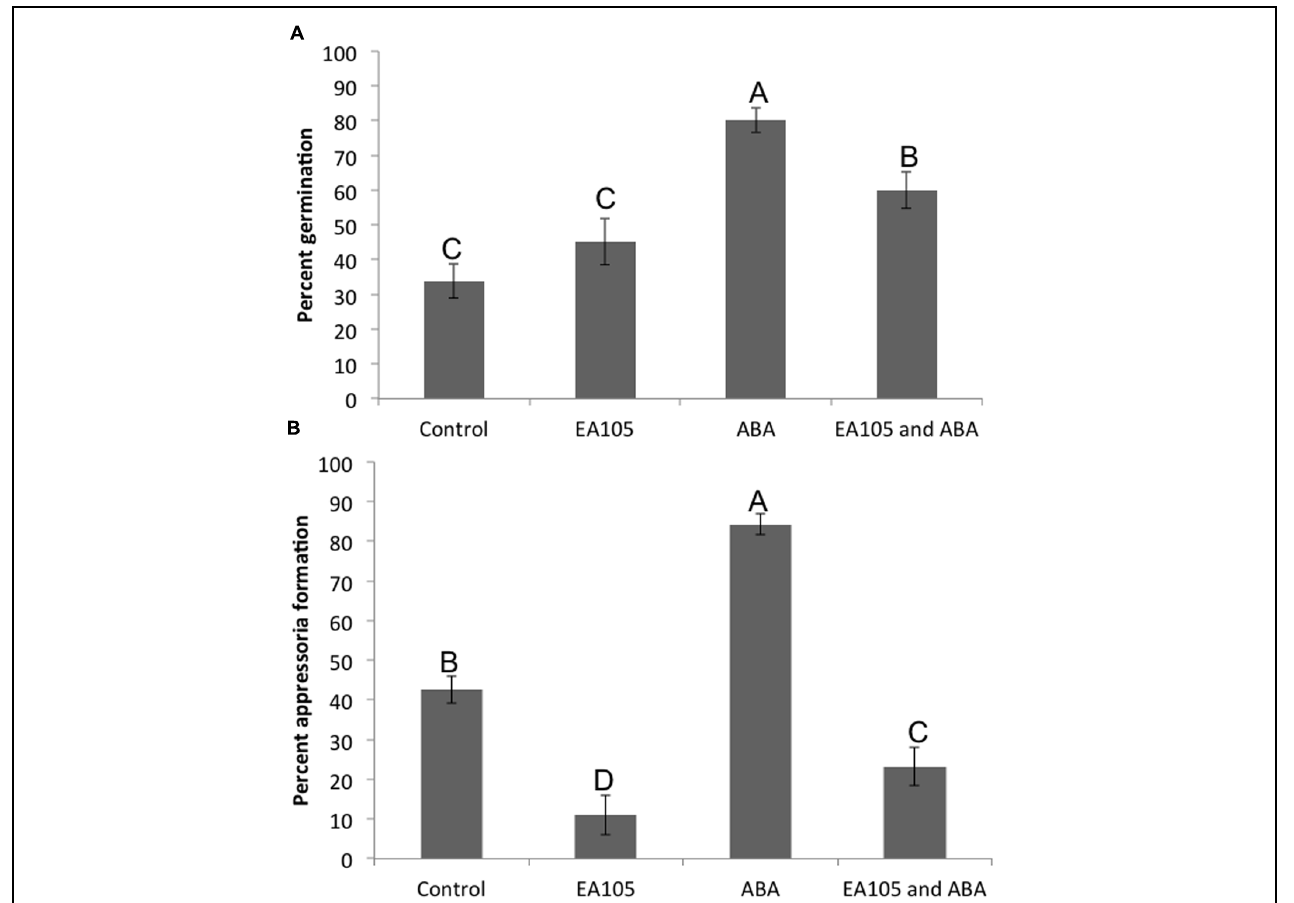
FIGURE 4 | Magnaporthe oryzae 70-15 spores treated with EA105 and/or exogenous ABA. (A) Percent germination was quantified at 2 h post treatment and (B) percent appressoria formation was quantified at 6 h post treatment. The experiment was repeated three times with five coverslips per treatment and three images per coverslip. Different letters represent statistical significance based on the Tukey-Kramer test ( p <